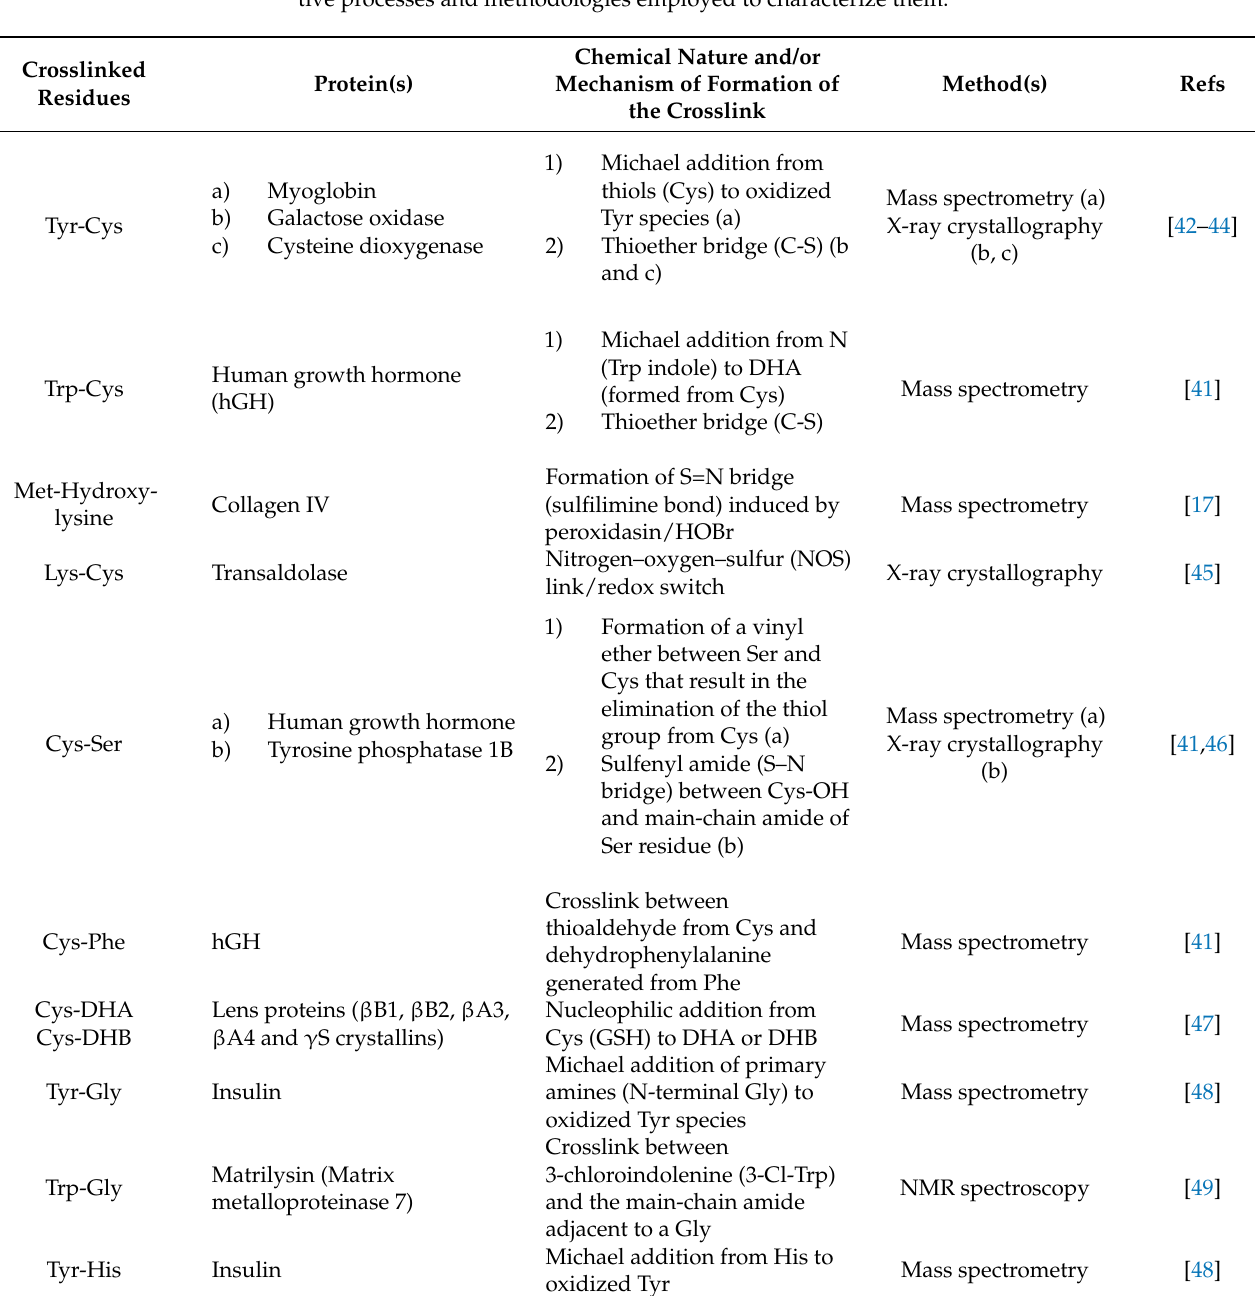
Table 1. Examples of major non-disulfide protein crosslinks generated during non-enzymatic oxida- tive processes and methodologies employed to characterize